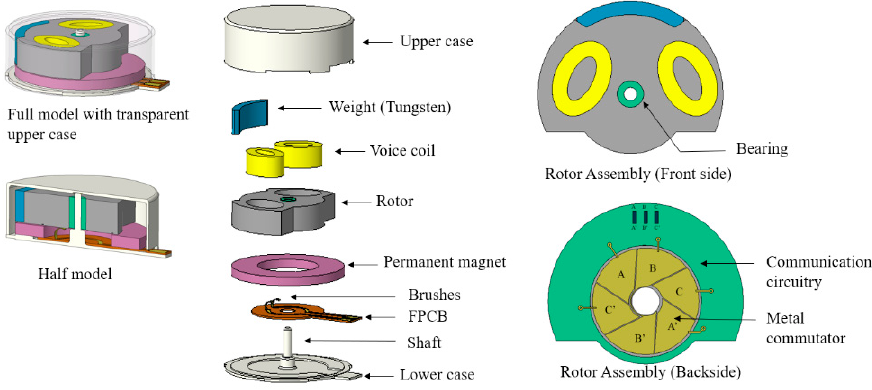
Figure 1. The exploded view and a cross-sectional view of a coin-type vibration motor.